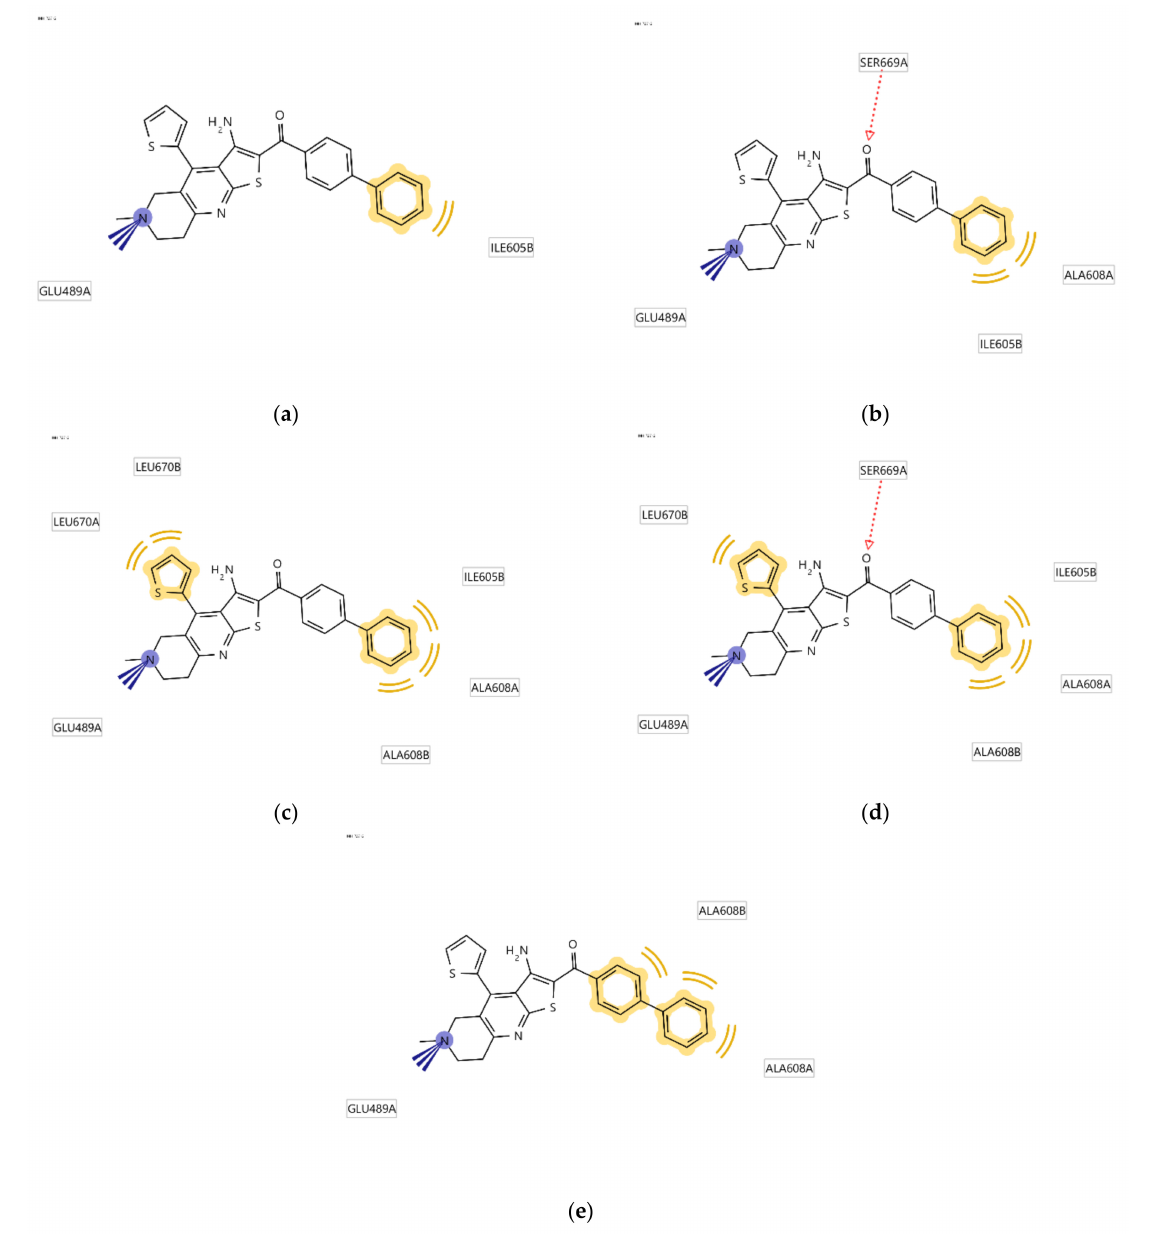
Figure 5. Schematic representation of the five most frequently appearing pharmacophore models during the MD trajectory ( a – e ).